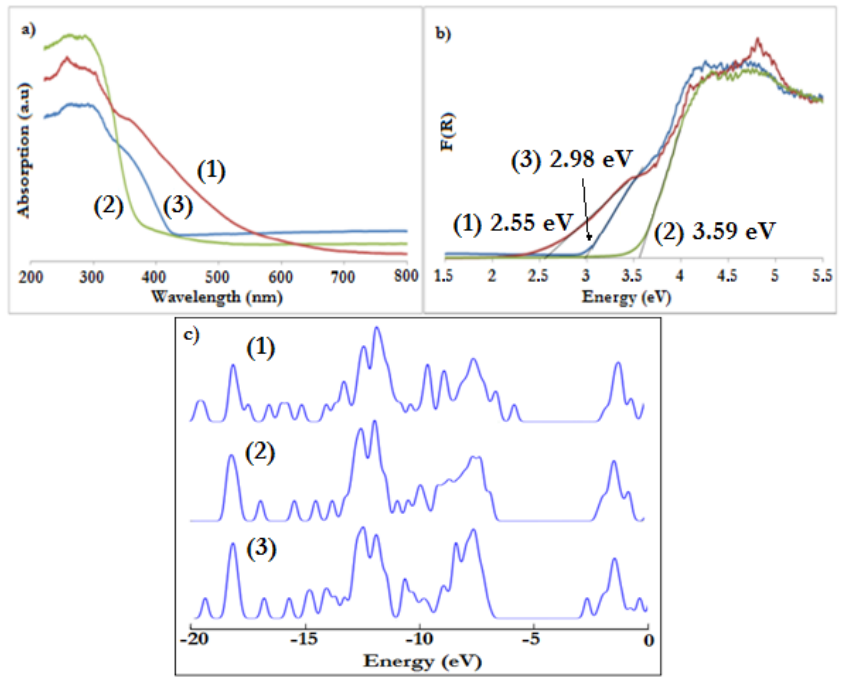
Figure 2. ( a ) Solid-state UV-Vis absorption spectra of ( 1 )–( 3 ) micrograins; ( b ) Kubelka–Munk function versus light energy plot used for band gap determination; ( c ) density-of states (DOS) plots calculated with HSE06/6-31G(d,p) level of theory for (Ti 4 O 2 (OMe) 10 (OOC-C 13 H 9 ) 2 ) ( 1 ), (Ti 4 O 2 (OMe) 10 (OOC-C 6 H 4 -Cl) 2 ) ( 2 ), and (Ti 4 O 2 (OMe) 10 (OOC-C 6 H 4 -NO 2 ) 2 ) ( 3 ).